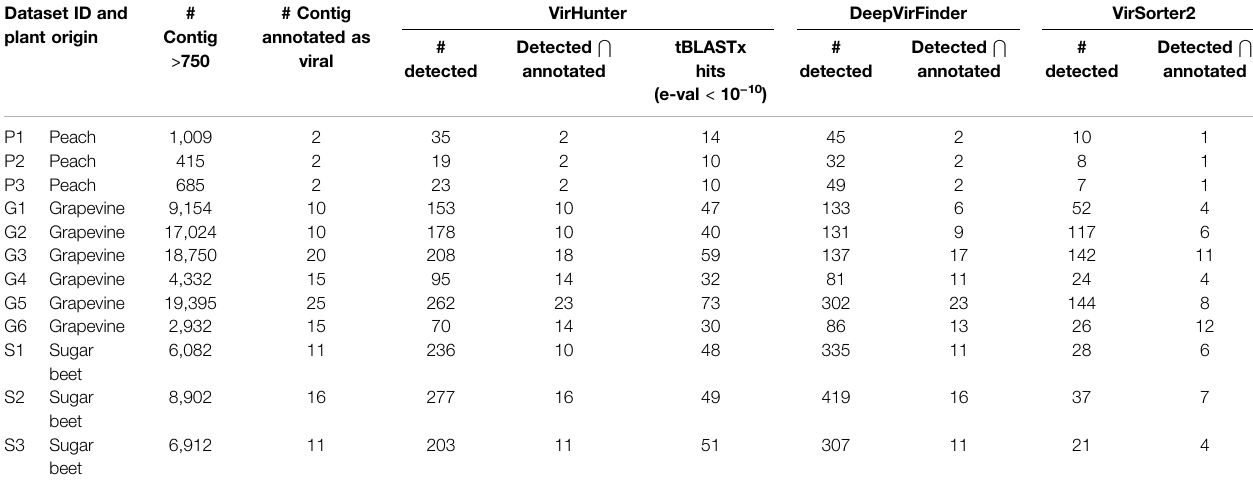
TABLE 2| PerformanceofVirHunter, DeepVirFinder, and VirSorter2on 12RNAseq viromedatasets.Foreach ofthe12datasetsshown arethenumber ofcontigsthatwere annotated as being viral by experts and the number of contigs in the initial assembly with length > 750. Columns “ VirHunter, ” “ DeepVirFinder, ” and “ VirSorter2 ” show predictions run onthese contigsbyeach method.Columns “ #detected ” show thetotal number ofcontigs detected asbeing viralbyeach ofthetwomethods, and columns “ detected ∩ annotated ” indicates how many of these were previously identi fi ed by the curators. Finally, the “ tBLASTx e-value < 10 − 10 ” column indicates how many of “ # detected ” contigs align against viruses for